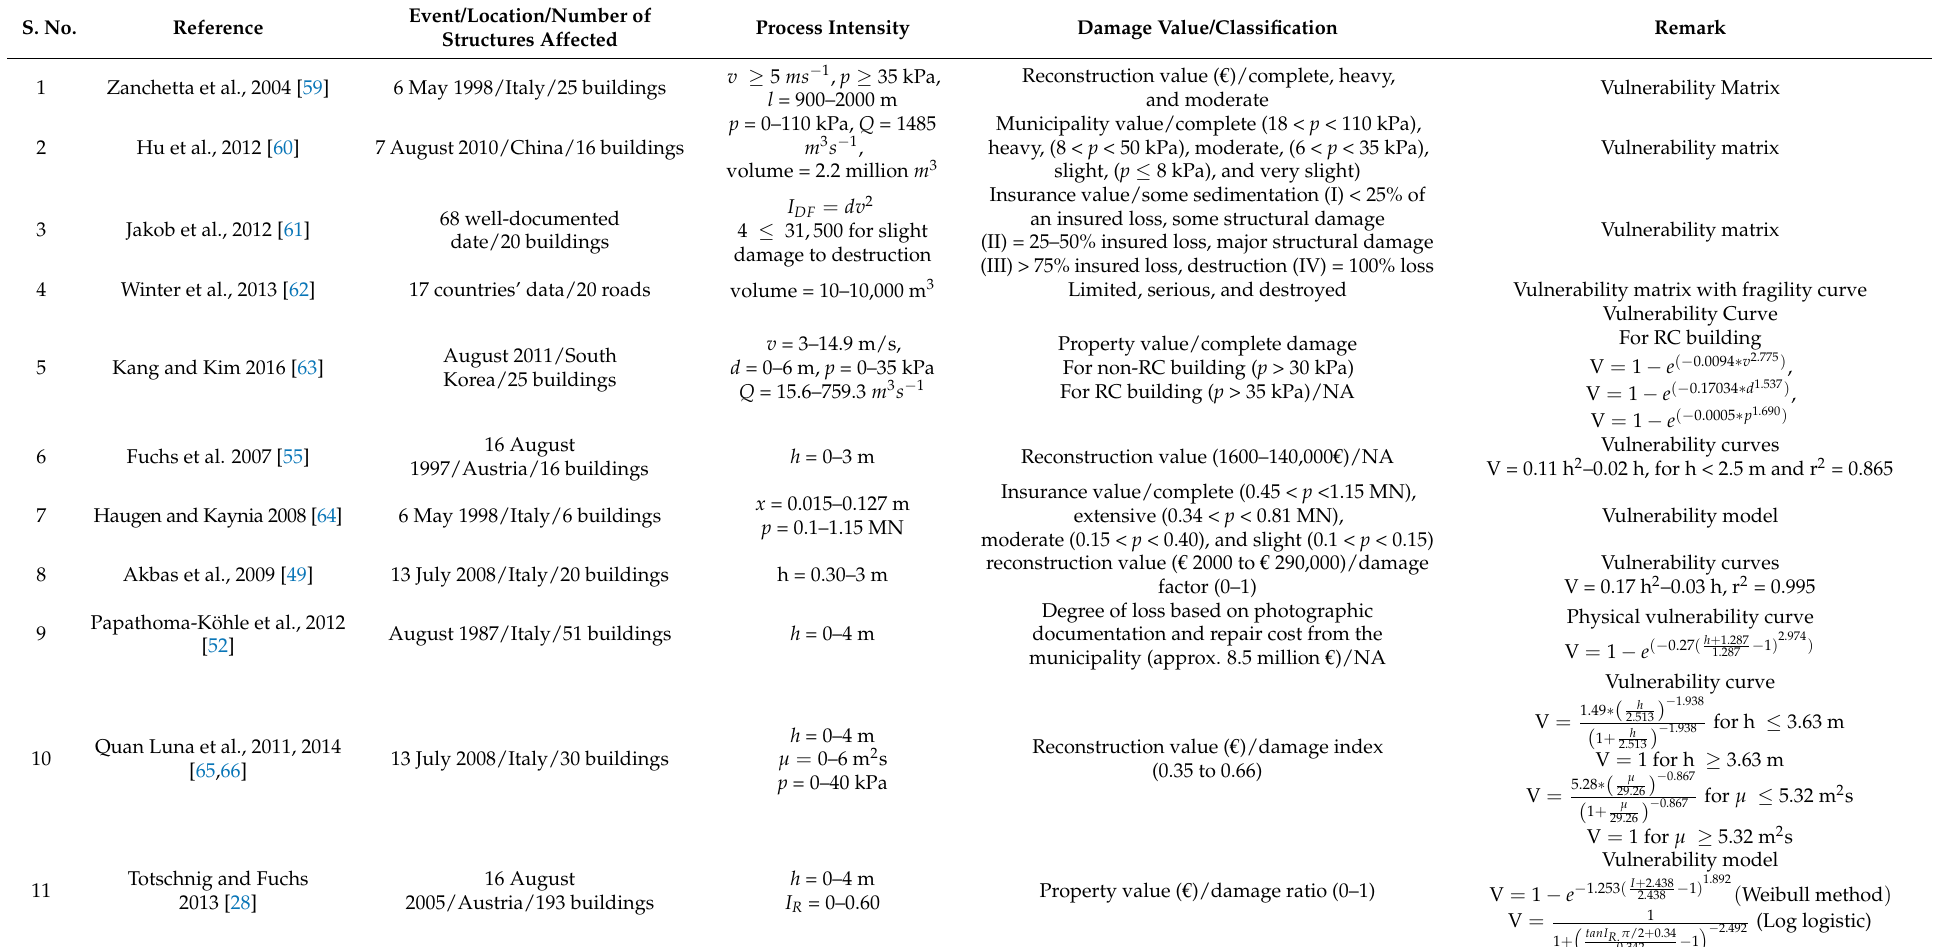
Table 1. Review of existing vulnerability approach for mountainous